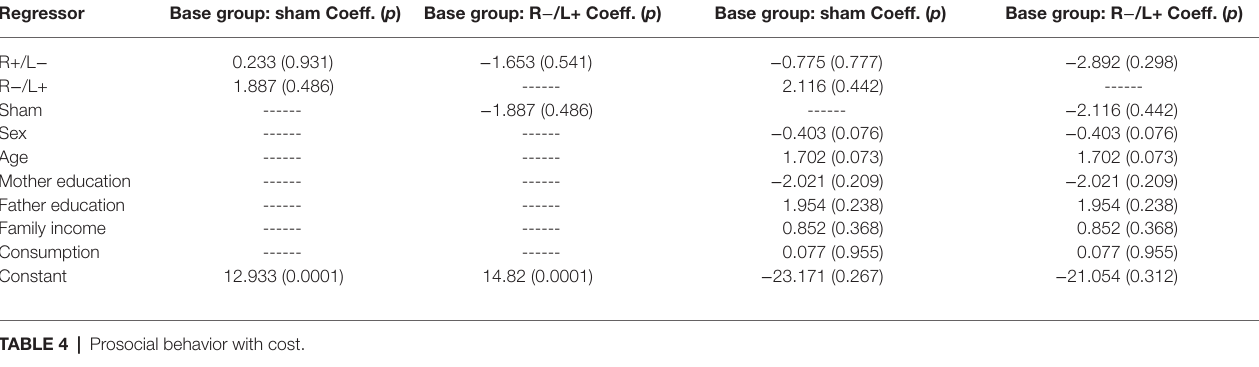
TABLE 4 | Prosocial behavior with cost. Regressor